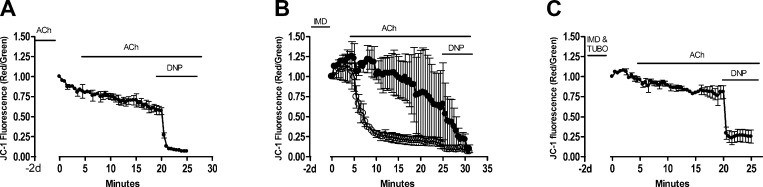
Chronic exposure to low levels of imidacloprid increases mitochondrial vulnerability. Bumblebee neurons (3–10 DIV) exposed chronically for 2 days (−2 days to 0 minutes) to (A) ACh (100 μM) do not induce vulnerability to mitochondrial depolarization by a subsequent exposure to subeffect ACh (100 μM). B) Low level imidacloprid (1 nM) induces vulnerability to a subsequent exposure to subeffect ACh (100 μM), revealing fast responders (open circles) and slow responders (filled circles). Nonresponders not shown. C) Low level imdacloprid (1 nM) and tubocurarine (500 µM) coexposure prevents development of mitochondrial vulnerability to subeffect ACh (100 µM). In all cases, mitochondrial depolarization was monitored using JC-1 and the experiment was terminated by full mitochondrial depolarization by 2,4-dinitophenol (1 mM).